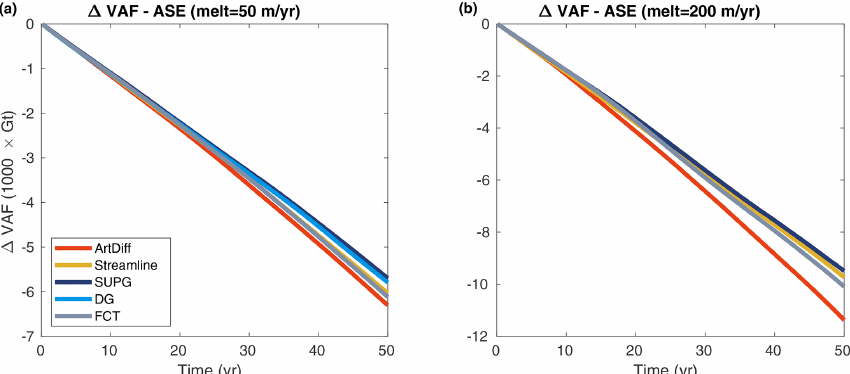
Figure 17. (cid:49) VAF along transient simulations for the Amundsen Sea Embayment (ASE) domain. The transient simulations are forced by two different basal melt rate scenarios: 50myr − 1 (a) and 200myr − 1 (b) . The basal melt is applied only on fully floating elements, and the parameterization schemes for basal friction and driving stress are SEP1 and NSED,